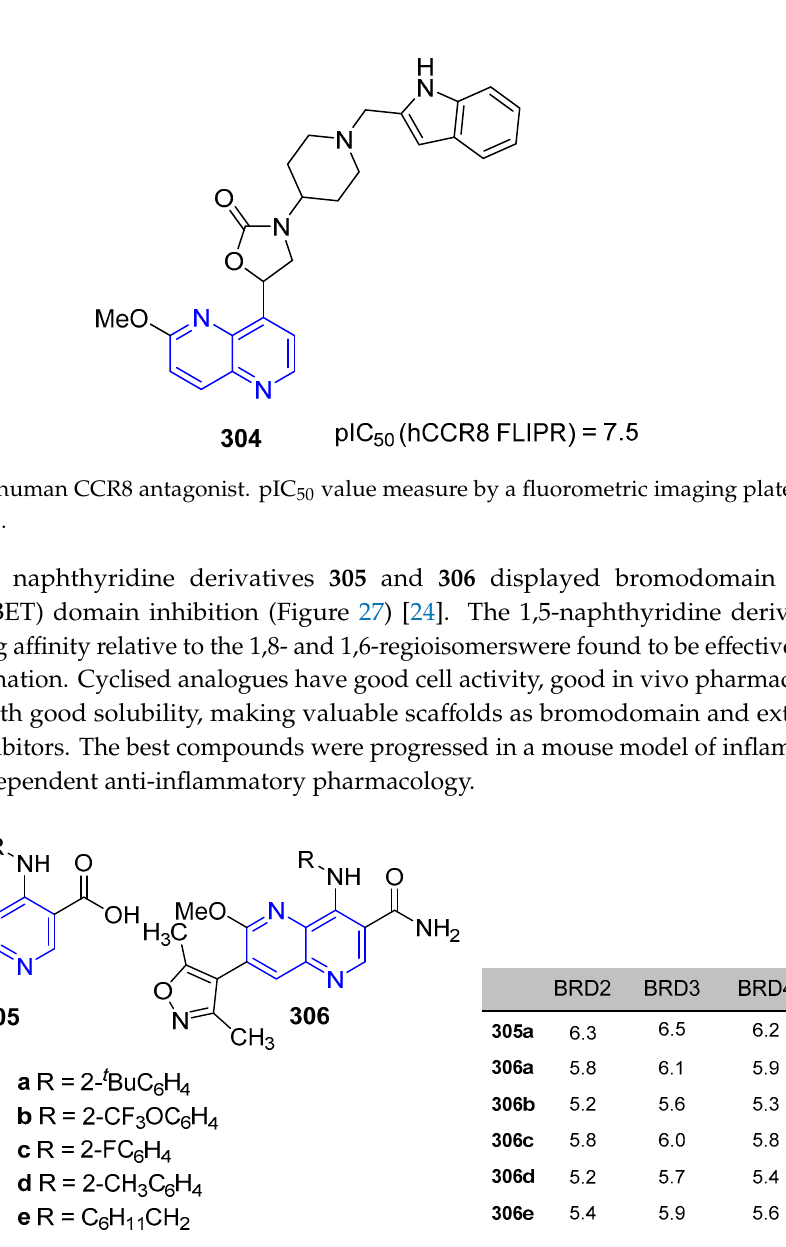
Figure 27. Inhibitors of bromodomain (BRD2-4) and peripheral blood mononuclear cells (PBMC) domain and their pIC 50 values.